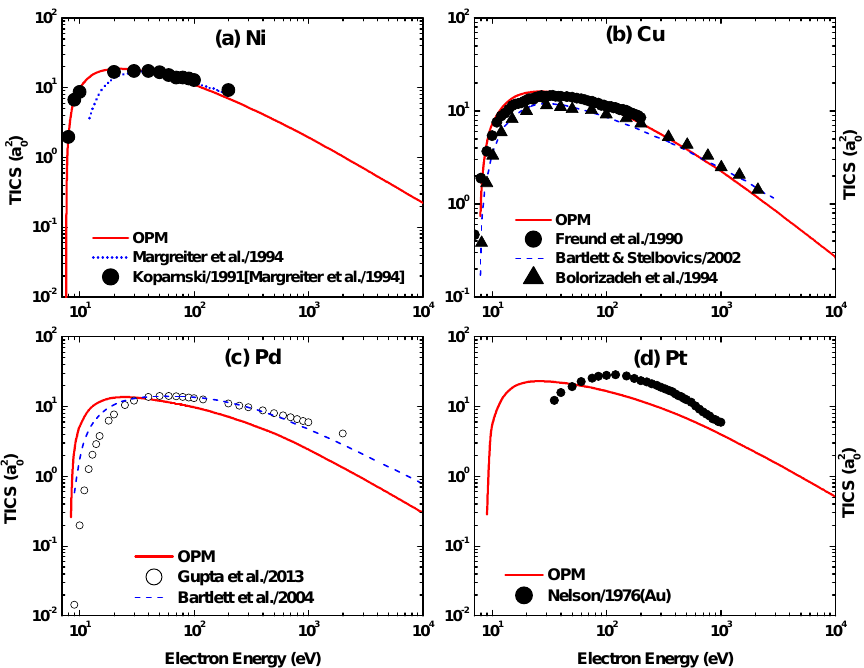
Figure 35. Energy dependence of the total ionization cross-section (TICS) for electron impact scat- tering from ( a ) Ni 58 , ( b ) Cu 63 , ( c ) Pd 108 , and ( d ) Pt 196 . Experiment: ( • ) Koparnski reported in [51] for Ni, Freund et al. [55] and ( (cid:78) ) Bolorizadeh et al. [56] for Cu, and Nelson [57] for Au.